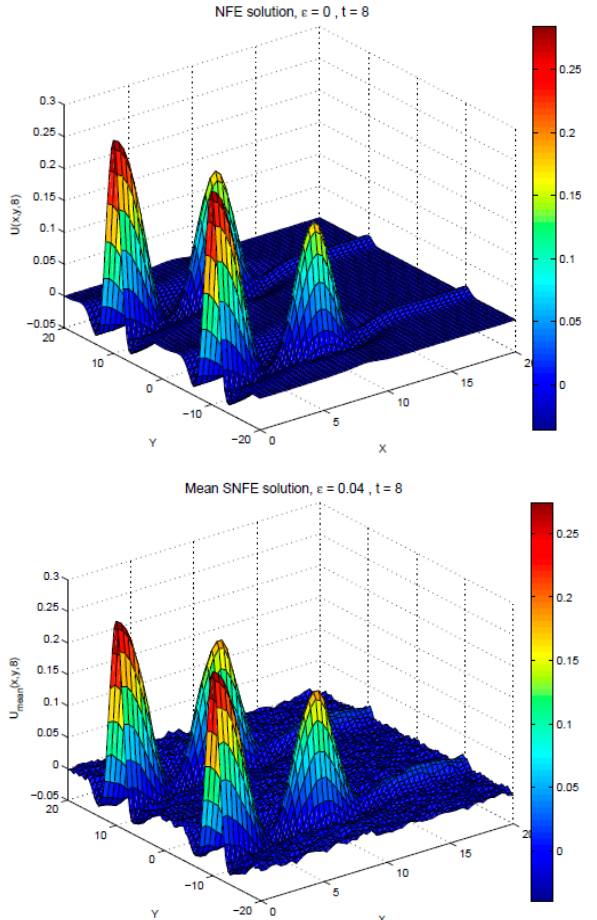
Figure 12. Snapshots of the solution of Example 3 at time t = 6: up- E = 0; down, left-hand side -E = 0.04; down, right- hand side - E = 0.08